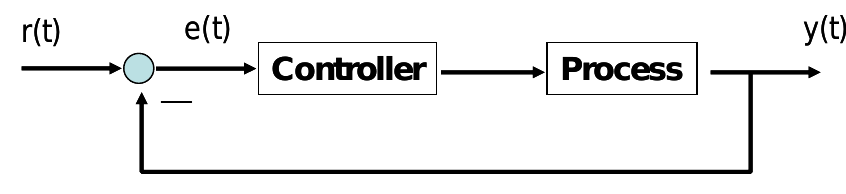
Fig. 1: Feedback Control system. r(t) corresponds to the desired or reference value for the process output y(t), while e(t) is the error signal computed as e(t)=r(t)-y(t).